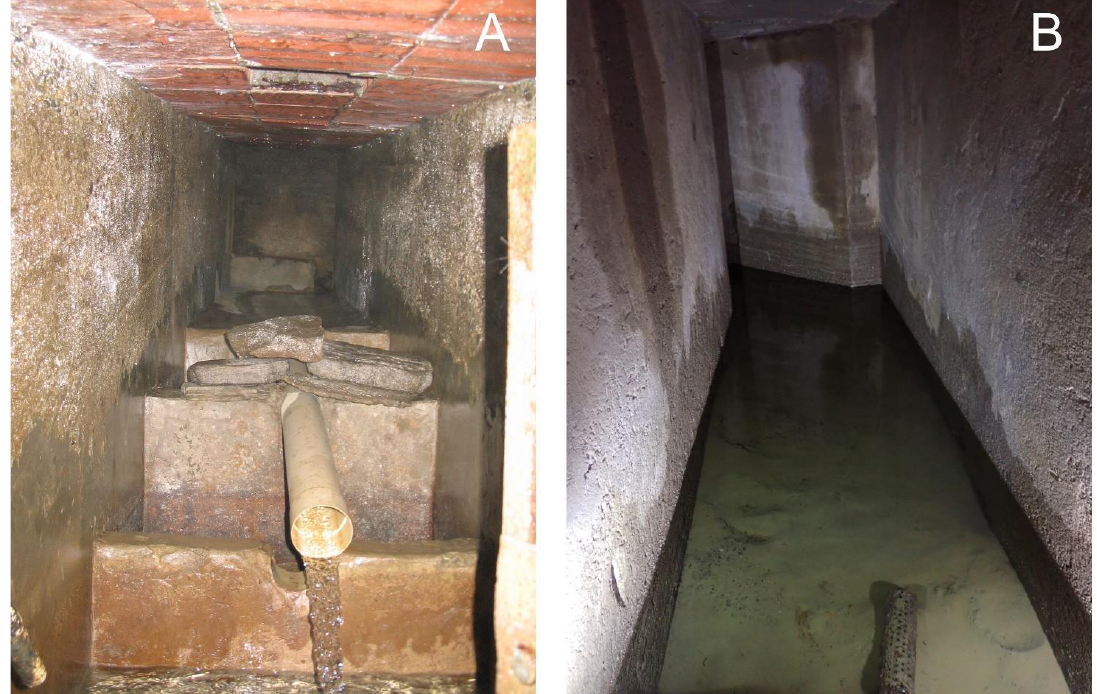
Figure 1. Sites of collection of Niphargus thuringius amphipods used during the experiment. ( A ) Short draining gallery in the locality of Valle Tolsera, Airuno municipality (Lecco, Northern Italy). ( B ) “Bottino di presa” in the municipality of Castello di Brianza (Lecco, Northern Italy). The animals were transferred to the subterranean biology laboratory and mixed in a